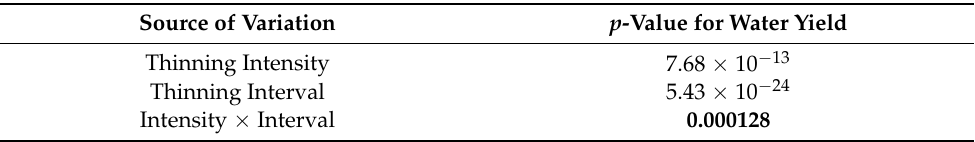
Table 4. Summary of two-way ANOVA test for water yield.